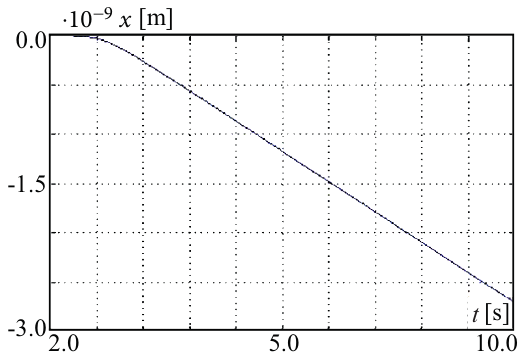
Fig. 10. Displacement along the OX